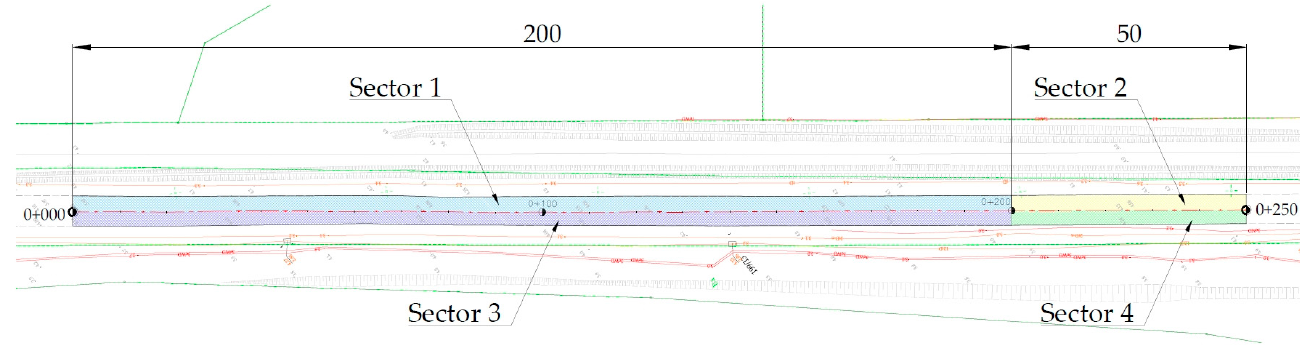
Figure 7. General layout of the Kartoszyno long test section.